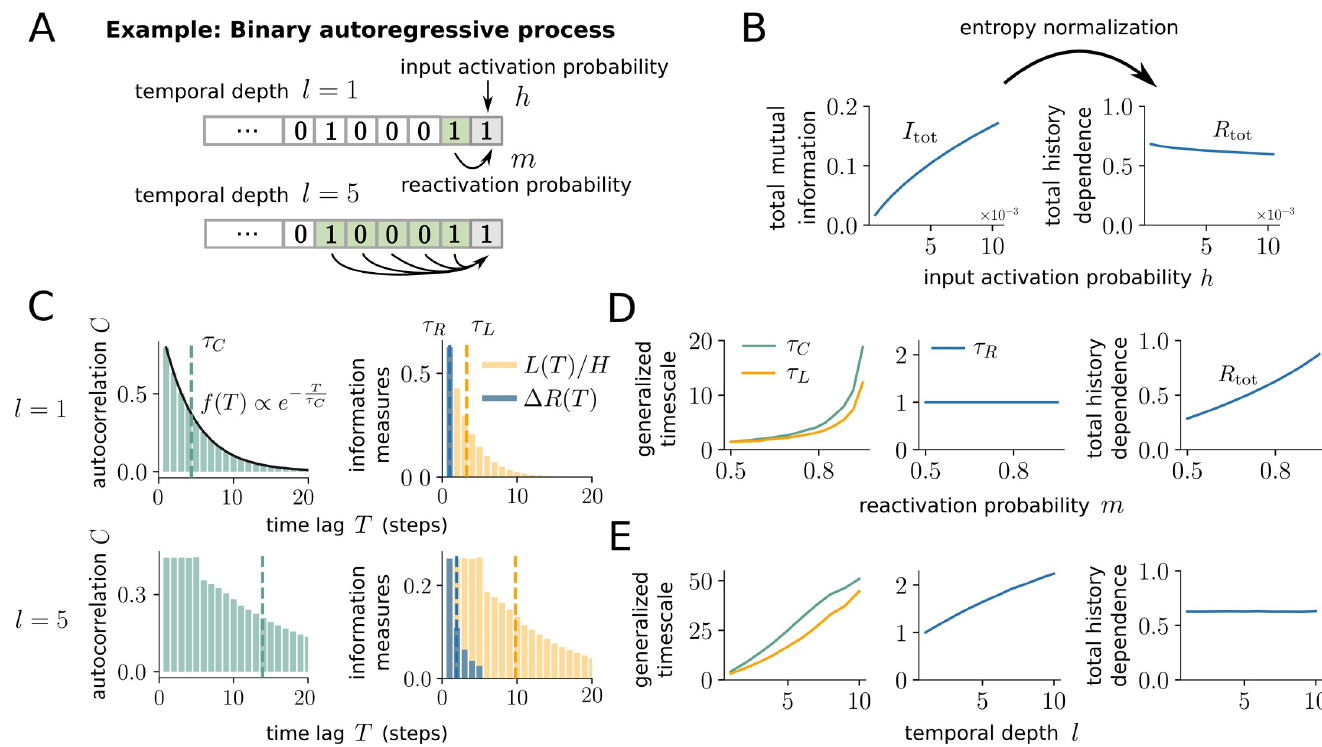
Fig 3. History dependence disentangles the effects of input activation, reactivation and temporal depth of a binary autoregressive process. (A) In the binary autoregressive process, the state of the next time step (grey box) is active (one) either because of an input activation with probability h , or because of an internal reactivation. The internal activation is triggered by activity in the past l time steps (green), where each active state increases the activation probability by m . (B) Increasing the input activation probability h increases the total mutual information I tot , although input activations are random and therefore not predictable. Normalizing the total mutual information by the entropy yields the total history dependence R tot , which decreases mildly with h . (C) Autocorrelation C ( T ), lagged mutual information L ( T ) and gain in history dependence Δ R ( T ) decay differently with the time lag T . For l = 1 and m = 0.8 (top), autocorrelation C ( T ) decays exponentially with autocorrelation time τ , whereas L ( T ) decays faster due to the non-linearity of the mutual information. For l = 5 (bottom), C ( T ) and L ( T ) plateau C over the temporal depth, and then decay much slower than for l = 1. In contrast, Δ R ( T ) is non-zero only for T shorter or equal to the temporal depth of the process, with much shorter timescale τ . Parameters m and h were adapted to match the firing rate and total history dependence between l = 1 and l = 5. (D) When increasing R the reactivation probability m for l = 1, timescales of time-lagged measures τ and τ increase. For history dependence, the information timescale τ remains constant, C L R but the total history dependence R tot increases. (E) When varying the temporal depth l , all timescales increased. Parameters h and m were adapted to hold the firing rate and R tot